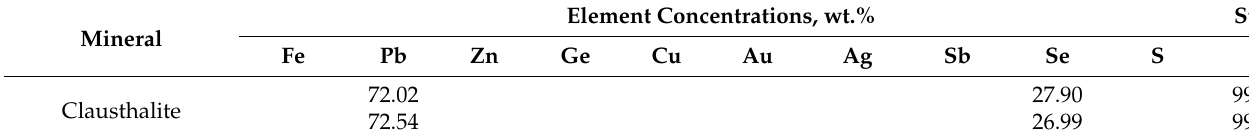
Table 3. Compositions of clausthalite and minerals of Au and